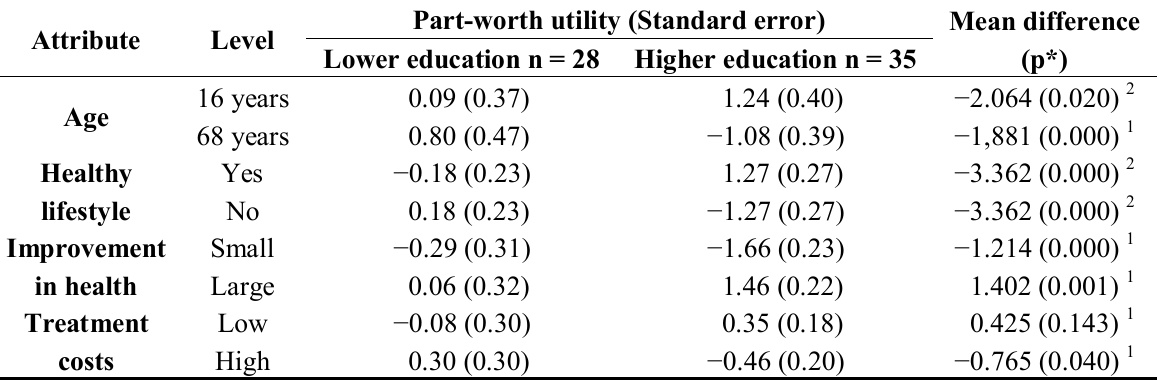
Table 7. Hypotheses testing: Differences between part-worth utilities estimated for participants with lower and higher